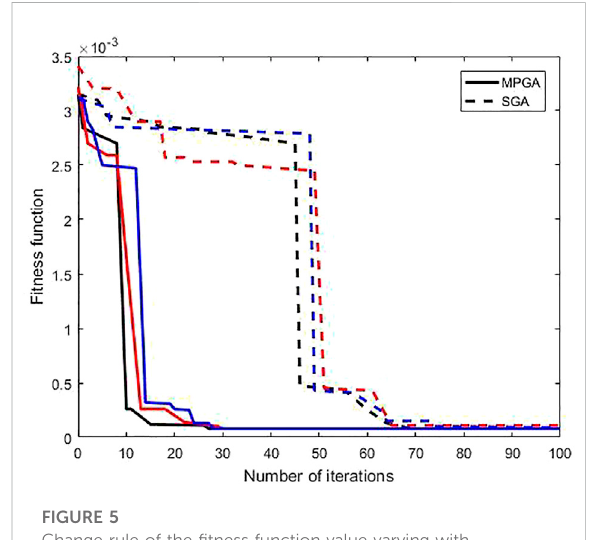
FIGURE 5 Change rule of the fi tness function value varying with iteration times with SGA and MPGA.